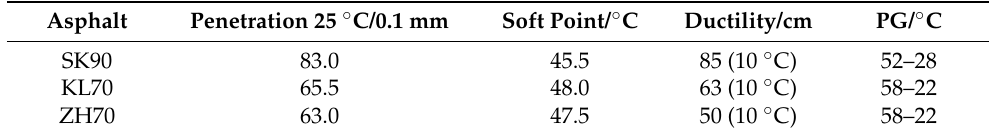
Table 1. Properties of Asphalt Binders.